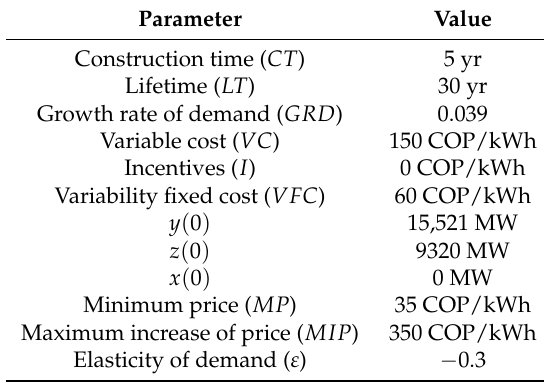
Table 2. Parameters used in the model based on the Colombian electricity